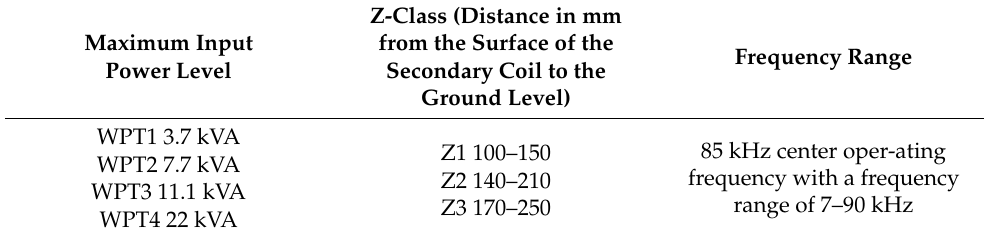
Table 3. Summary of the SAE J2954 standard recommendations